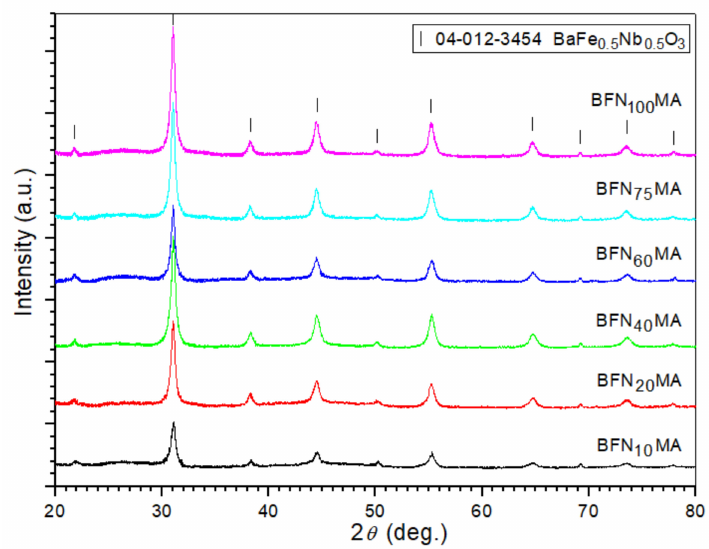
Figure 1. X-ray diffraction (XRD) patterns of the BaFe 1/2 Nb 1/2 O 3 (BFN) powders after different periods of high-energy